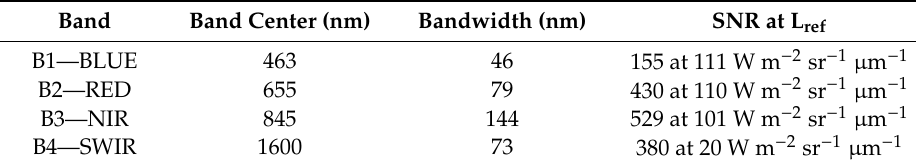
Table 1. Spectral and radiometric specifications of Proba-V